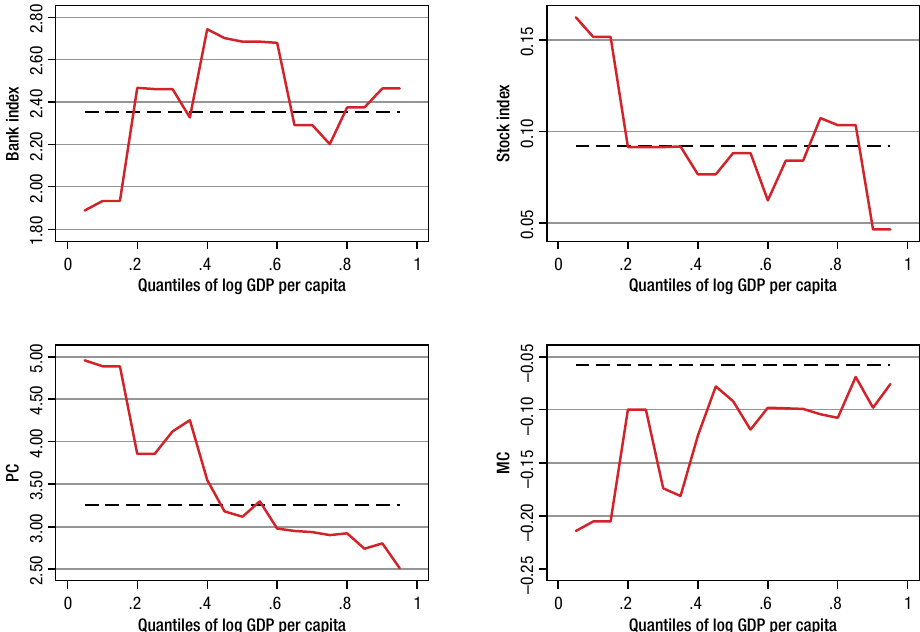
Fig. 2. Quantile and OLS coefficients of banking sector and stock market development index, private credit and market